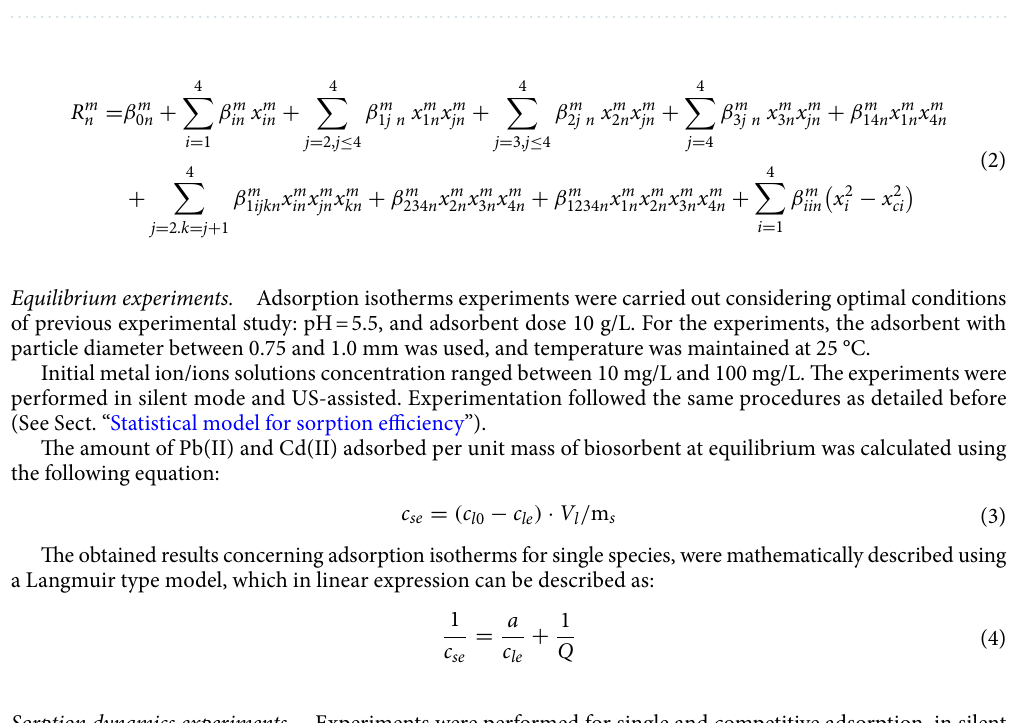
Table 2. Coded experimental design matrix as a function of the independent variables (x 1 , x 2 , x 3 and x 4 ) and separation efficiency (R) obtained for silent adsorption and US-assisted